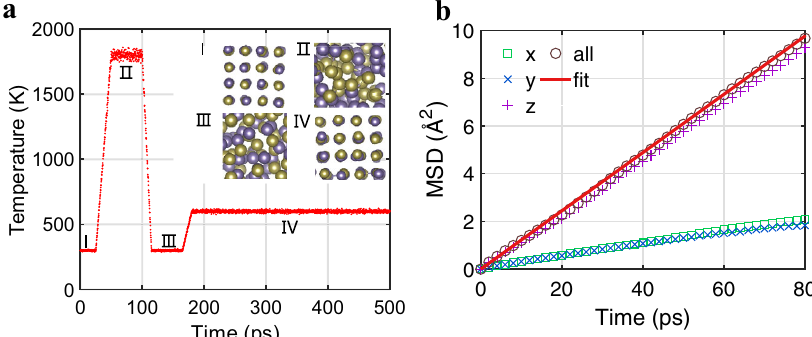
Fig. 3 The molecular dynamics simulation results of GeTe and Li 10 GeP 2 S 12 using the proposed NVNMD. In panel a , the phase transition processes of GeTe is reproduced, which contains initial crystalline phase (I), liquid phase (II), amorphous phase (III), and recrystallization (IV) shown in the insets. In panel b , the mean square displacement (MSD) of Li 10 GeP 2 S 12 is computed using NVNMD and the diffusion coef fi cient is extracted from its fi tting line. The components of x , y , and z direction show the anisotropic